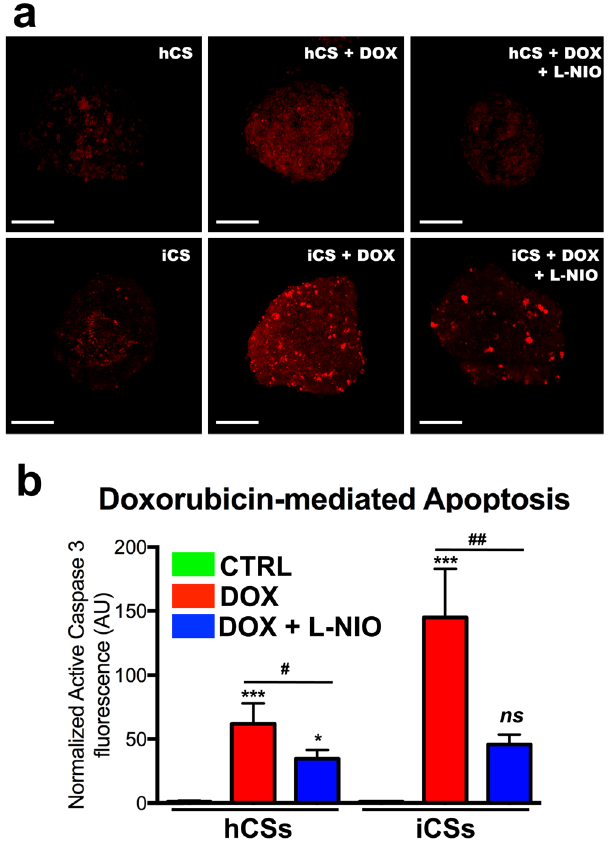
Figure 5. Doxorubicin-mediated apoptosis is inhibited by L-NIO. ( a ) Confocal analysis of hCSs and iCSs cultured with and without 20 μ M DOX and 100 μ M L-NIO and stained with antibodies against active caspase 3 (shown in red). ( b ) Statistical analysis ( n = 3) of black-versus-white ratios of confocal images of hCSs and iCSs cultured and stained as described in panel (a). Data are presented as mean ± SEM. Scale bars: 200 μ m. One-way ANOVA followed by Bonferroni’s multiple comparisons test. F (df 5, 12) =